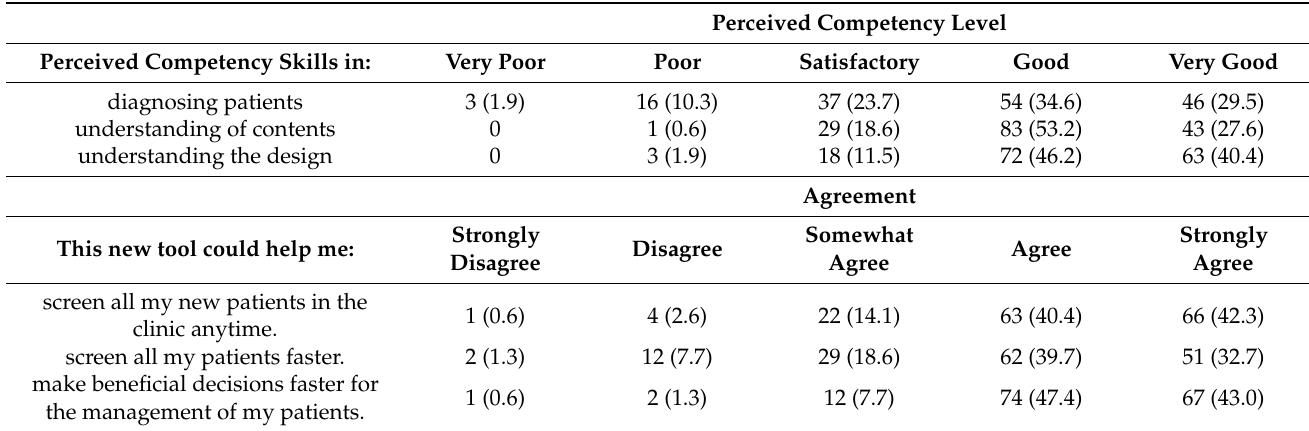
Table 3. Students’ perceived competency and acceptance of using the new assessment tool.